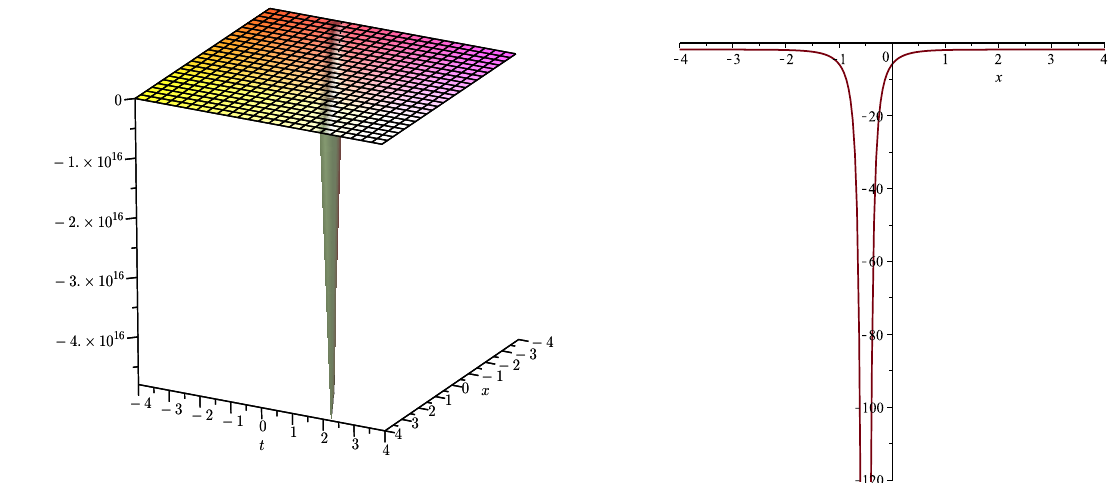
Figure 1. ( left ) 3D representation of solution (26) for ν = 1.5, κ = 1, ω = x , t ξ 0 = 0.5 and 4 4. ( right ) 2D representation of solution (26) with t = 0 and − ≤ ≤ singular soliton.